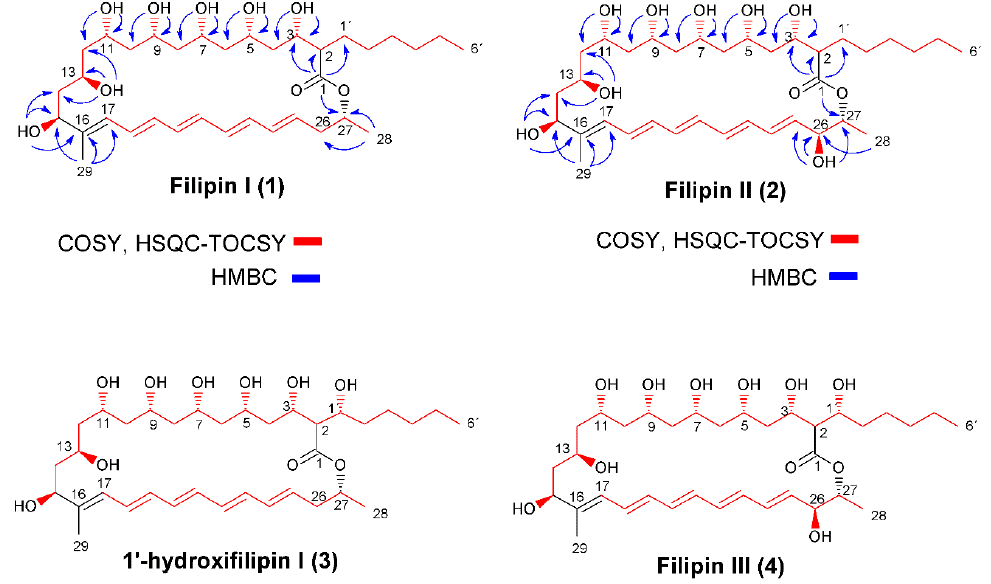
Figure 1. Chemical structures of filipin III and its precursors. COSY (H,H-correlation spectroscopy) and heteronuclear single quantum coherence (HSQC)-TOCSY correlations, as well as key heteronuclear multiple-bond correlation (HMBC) correlations for filipin I (1) and filipin II (2) are